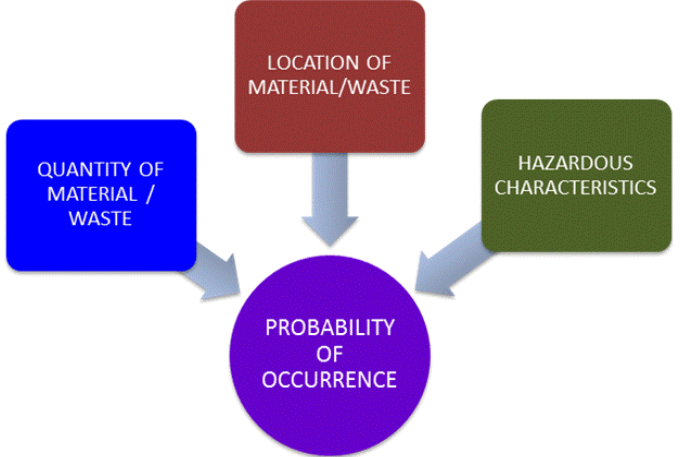
Figure 1. The three factors affecting the probability of contamination of the